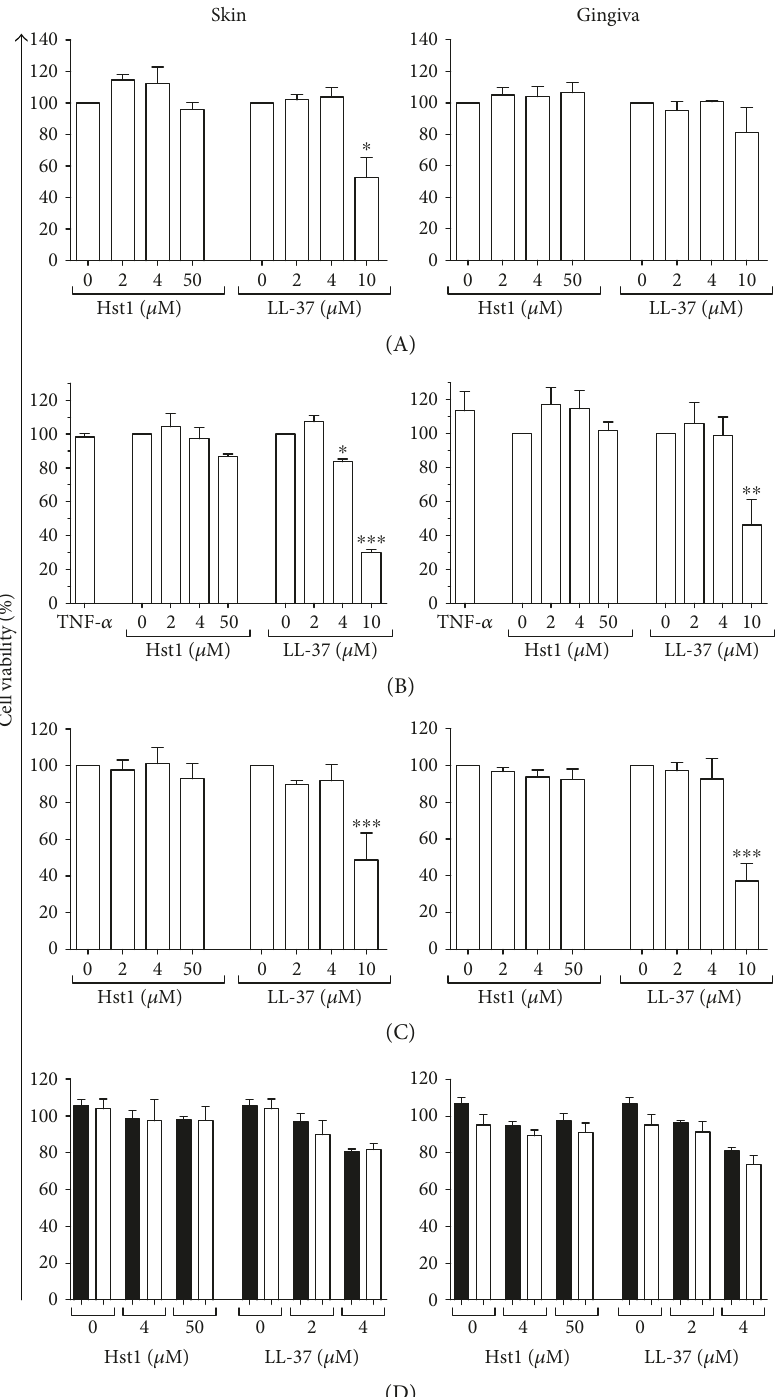
Figure 1: Cell viability after exposure to Hst1 and LL-37. Cell viability is shown after 24-hour exposure to Hst1 and LL-37 of (A) keratinocyte monolayer, (B) fi broblast monolayer, (C) keratinocyte- fi broblast coculture, and (D) keratinocyte- fi broblast coculture with neutralizing antibodies to IL-1 α (white bars) or isotype control (black bars). Each bar represents the mean ± standard error mean of 3 independent experiments each performed in duplicate, except that in (D) ( N = 4 ). ∗ P < 0 05 , ∗∗ P < 0 01 , and ∗∗∗ P < 0 005